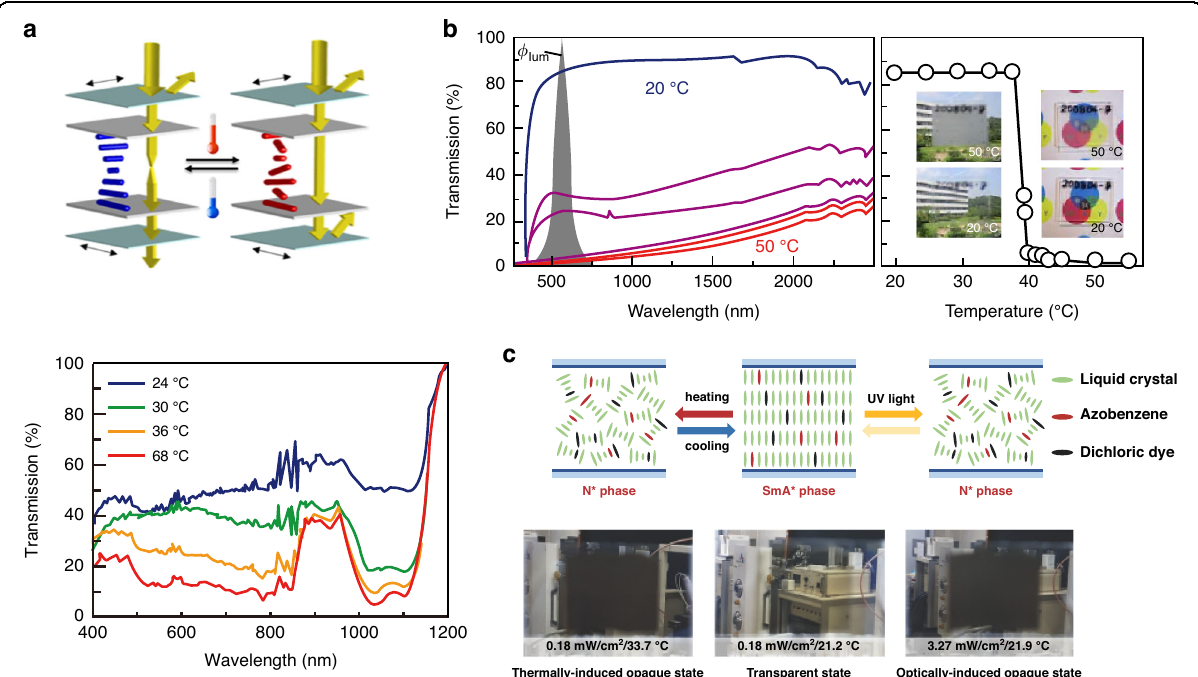
Fig. 17 Non-electrically switchable optical devices. a The relationship between transmittance and wavelength at different temperatures and the schematic diagram of device adjustment. Reproduced with permission from ref. 178 . Copyright 2021, Wiley Online Library. b Relationship between transmittance and wavelength at different temperatures and sample effect diagram. Reproduced with permission from ref. 179 . Copyright 2021, American Chemical Society. c Schematic diagram of the regulation principle of light and heat dual stimulation and the sample effect diagram. Reproduced with permission from ref. 180 . Copyright 2018, Wiley Online Library